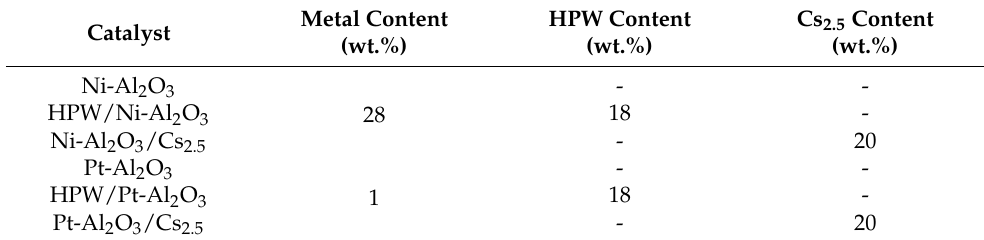
Table 3. Summary of the catalysts prepared